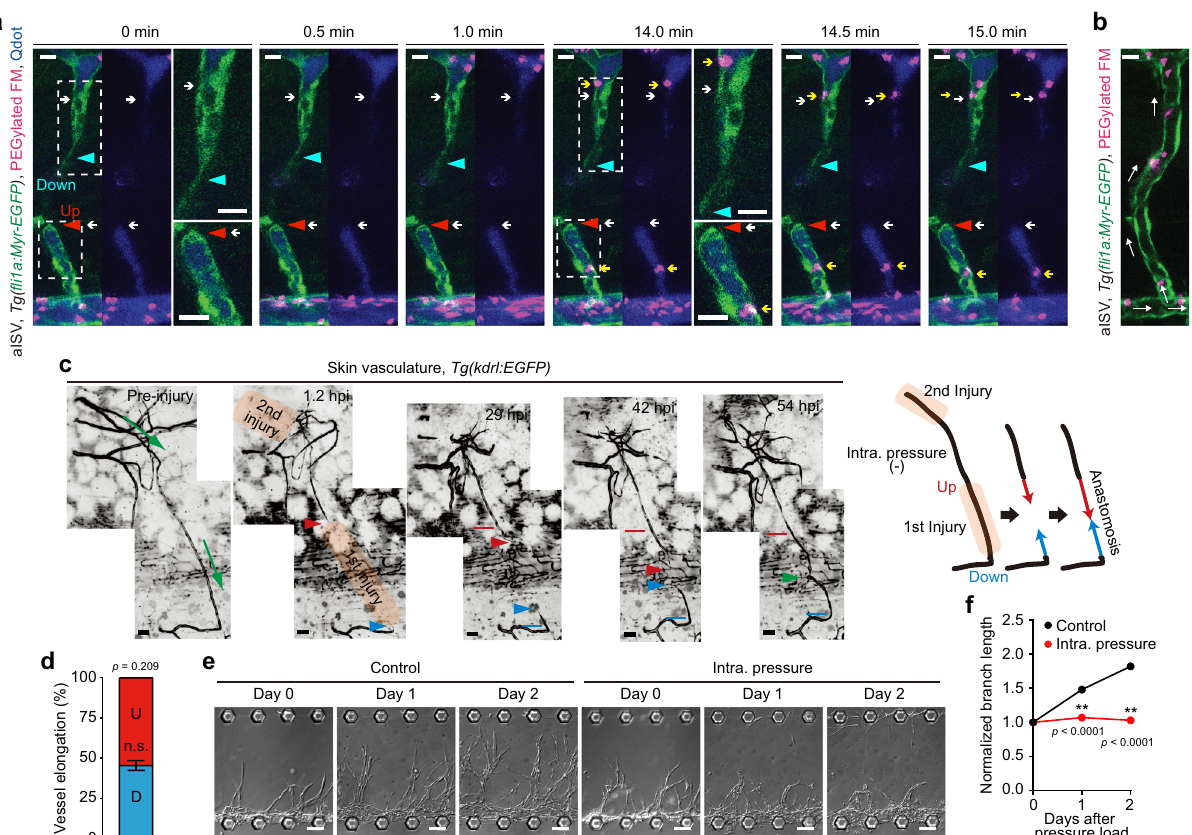
Fig. 2 Blood fl ow-driven IP loading restricts elongation of injured blood vessels upstream from blood fl ow during wound angiogenesis. a Confocal z - projection image of injured aISV in 3 dpf Tg( fl i1a:Myr-EGFP) larva intravascularly injected with PEGylated FM and Qdots (Qdot 705) and their subsequent timelapse images at the elapsed time indicated at the top. Image acquisition was started at 2.7 hpi and 37 min after the injection. Lateral view, anterior to the left. Left, merged images of EGFP (green), PEGylated FM (magenta), and Qdots (blue); right, merged images of PEGylated FM (magenta) and Qdots (blue). Boxed areas are enlarged on the right. Red and blue arrowheads, leading edges of upstream and downstream injured vessels, respectively; white arrows, tip of upstream and downstream injured vessels fi lled with Qdots; yellow arrows; PEGylated FM inside the injured vessels. b Confocal z -projection image of trunk vasculature (aISV) in 3 dpf Tg( fl i1a:Myr-EGFP) larva intravascularly injected with PEGylated FM. Lateral view, anterior to the left. Merged image of EGFP (green) and PEGylated FM (magenta). White arrows, the direction of blood fl ow. c Time-lapse confocal z -projection images of elongation of an injured skin capillary of adult zebra fi sh in which IP of the upstream injured vessel was relieved by cutting the more upstream site are as in Fig. 1b. Red and blue lines indicate the positions of the tips of upstream and downstream injured vessels at 1.2 hpi, respectively. d , Amounts of elongation of upstream (red) and downstream (blue) injured vessels as observed in c are as in Fig. 1c. ( n = 4 animals). n.s., not signi fi cant by two-sided t test. e , f Effects of vascular IP loading on branch elongation of on-chip angiogenesis. e Serial DIC images showing elongation of angiogenic branches before and after loading without (Control) or with IP (Intra. pressure). f Quanti fi cation of branch lengths as observed in e . Normalized values relative to that before IP load are means ± s.e.m. ( n = 45 branches examined over 3 independent experiments for each). ** p < 0.01 by two-way ANOVA followed by Sidak ’ s test. Source data are provided as a Source data fi le. Scale bars: 10 µ m ( a , b ), 50 µ m ( c ), 100 µ m ( e